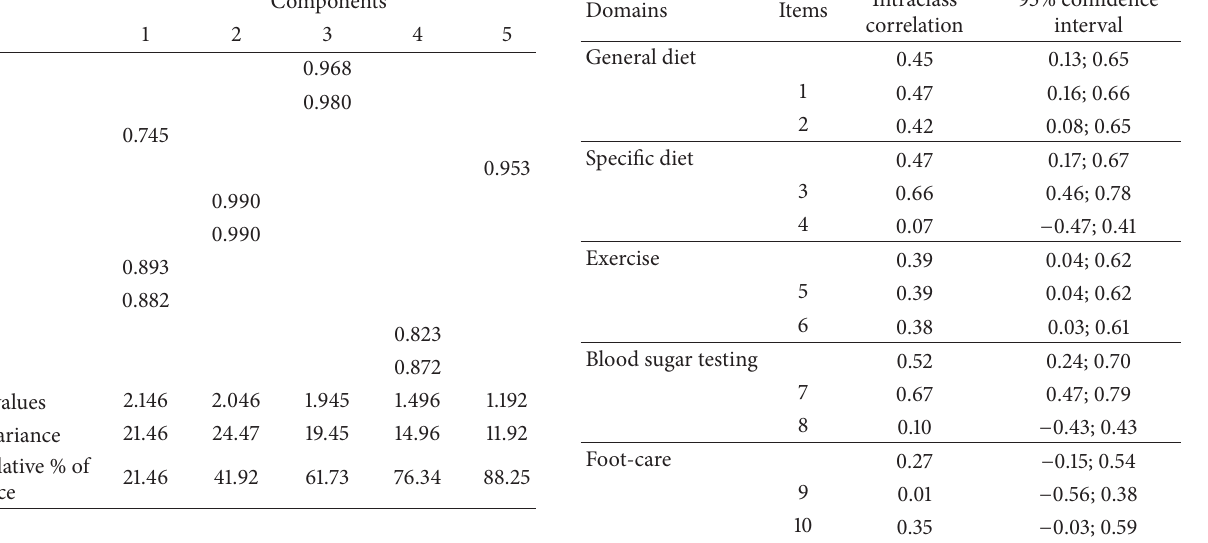
Table 4: Results of exploratory factor analysis of the Moroccan Summary of Diabetes Self-Care Activities items (8-item version: items 3 and 4 deleted): factors loadings and explained variance.